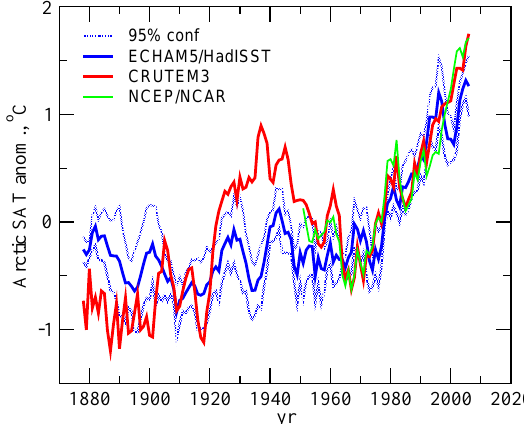
Fig. 3. Arctic (60 ◦ N–90 ◦ N) cold season (November–April) land SAT anomalies ( ◦ C) as observed (CRUTEM3, red) and computed in the ECHAM5 (HadISST) ensemble integrations. The thick blue line represents the ensemble mean; the dashed blue lines show the 95% confidence interval (according to Student’s t -test) estimated from the ensemble spread. The green line depicts the NCEP/NCAR reanalysis SAT. A 5-yr running mean filter was applied to all